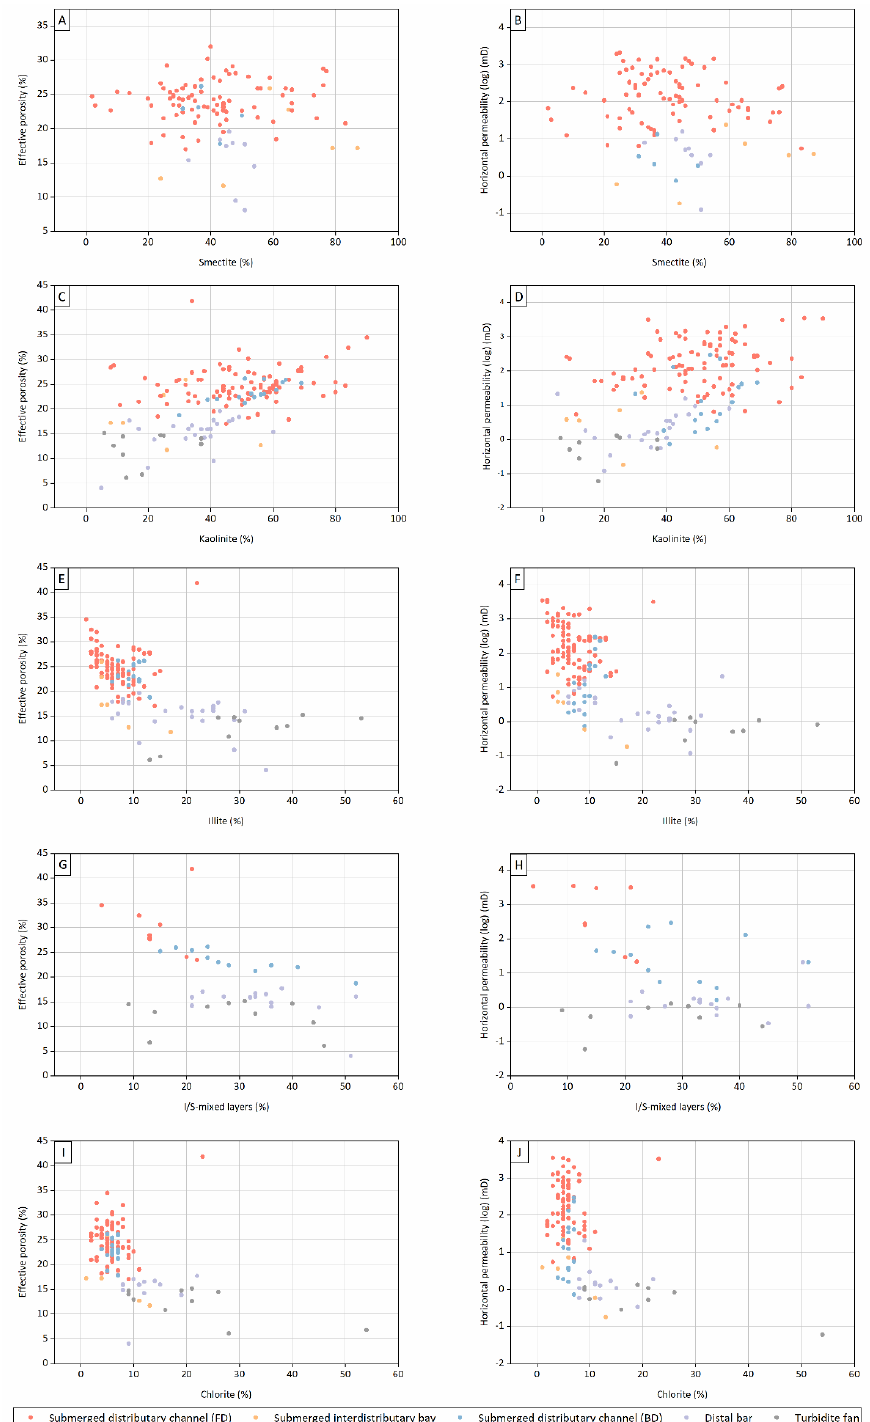
Figure 13. Plots of reservoir properties versus clay relative content derived from XRD, split by different sedimentary microfacies. ( A ) Core effective porosity versus smectite relative content; ( B ) Core horizontal permeability versus smectite relative content; ( C ) Core effective porosity versus kaolinite relative content; ( D ) Core horizontal permeability versus kaolinite relative content; ( E ) Core effective porosity versus illite relative content; ( F ) Core horizontal permeability versus illite relative content; ( G ) Core effective porosity versus I/S-mixed layer relative content; ( H ) Core horizontal permeability versus I/S-mixed layer relative content; ( I ) Core effective porosity versus chlorite relative content; ( J ) Core horizontal permeability versus chlorite relative